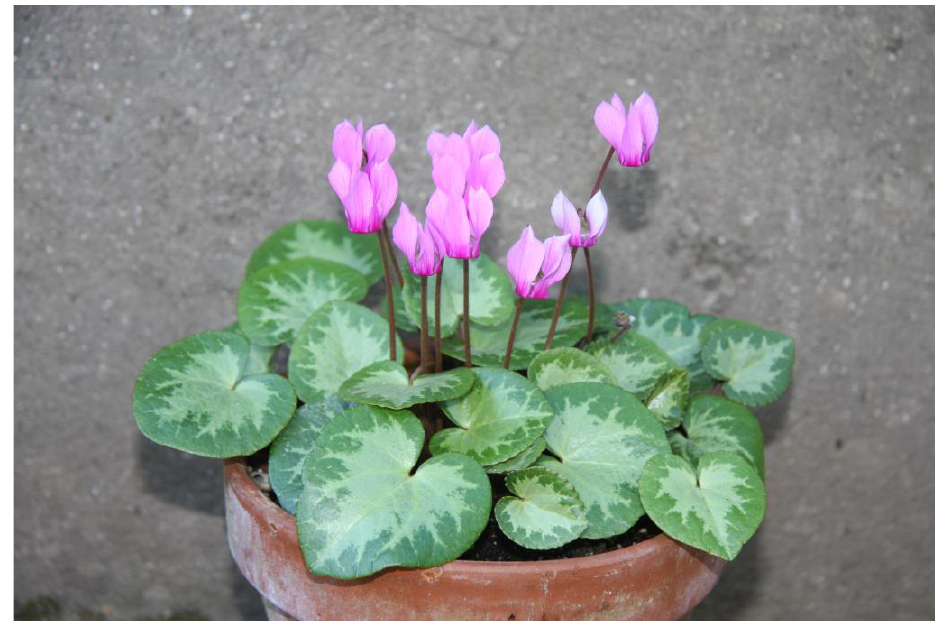
Figure 10. Cyclamen purpurascens ‘Plave’ .